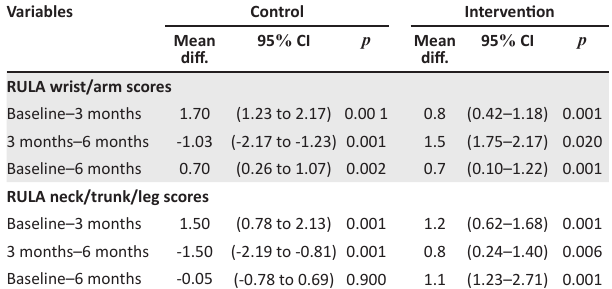
TABLE 6: Rapid upper limb assessment scores within groups over the study